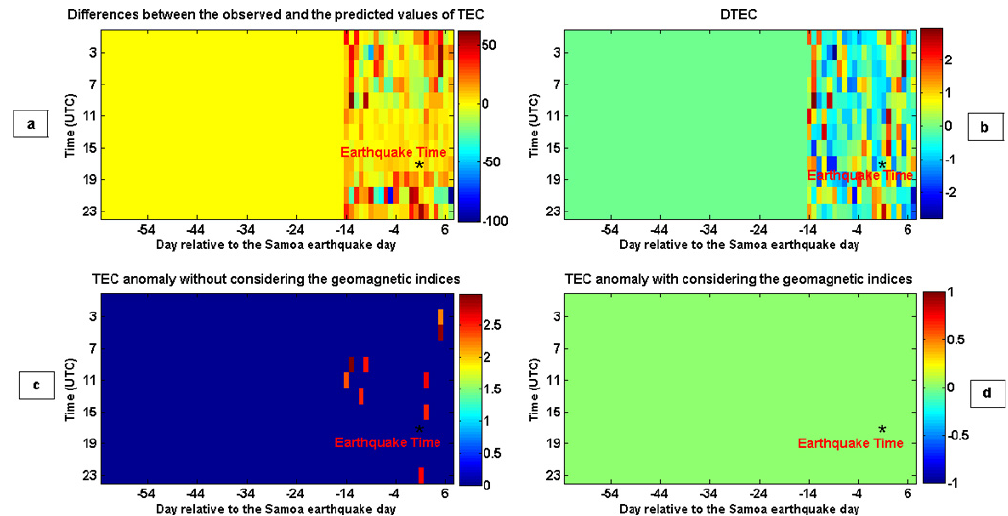
Fig. 14. (a) Differences between the observed and the predicted values of TEC. (b) DTEC variations. (c) Detected anomalies without considering the geomagnetic indices. (d) Detected anomalies with considering the geomagnetic indices.